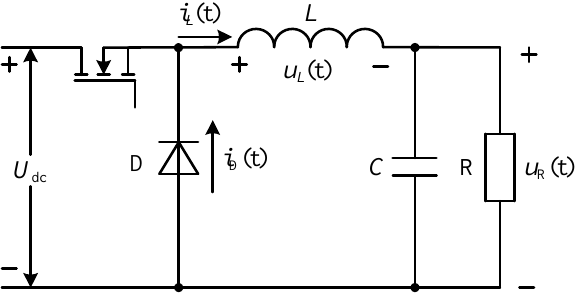
Figure 5. Load working principle and the Buck circuit.